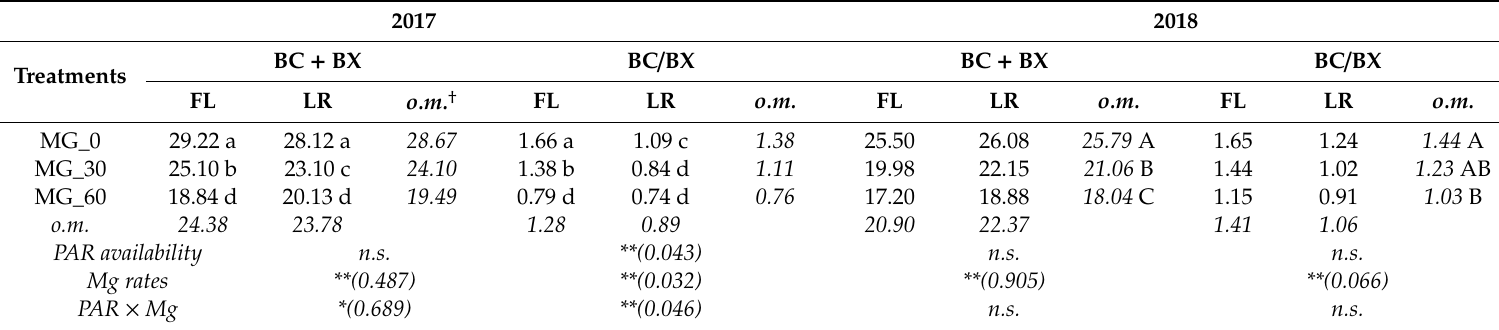
Table 6. Total betalains content expressed as the sum of betacyanins (BC, mg g − 1 ) and betaxanthins (BX, mg g − 1 ) (BC + BX) as well as the ratio of BC / BX as observed in the storage root of red beet plants subjected to two levels of photosynthetically active radiation (PAR) availability (100% PAR availability: Full Light, FL; 50%